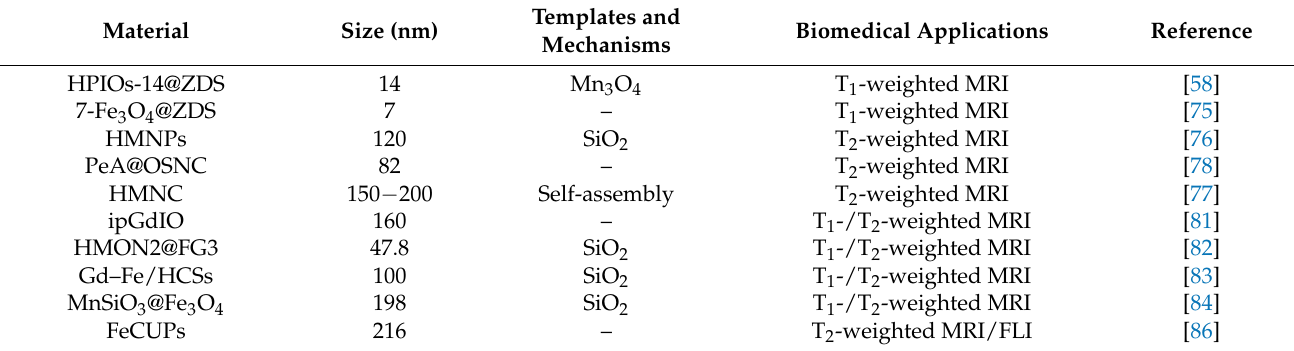
Table 1. Summary of various Fe-HNPs for cancer imaging and theranostics. Templates and Biomedical Mechanisms